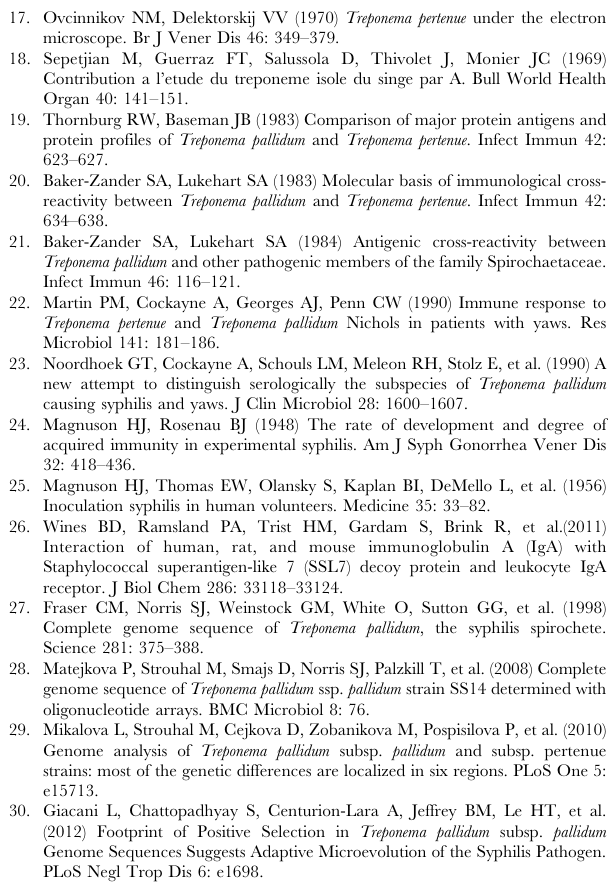
Figure S2 Alignment of amino acid sequences of the predicted protein sequences encoded at the tprD (2.1), tprC (2.2), and tprF and tprI (2.3) loci. The TprD2 truncated proteins encoded by the tprC/D loci in T. paraluiscuniculi , as well as by the tprF locus in T. p. pallidum strains are not included in the alignment for clarity purposes. Also, no T. paraluiscuniculi tprF and tprI ORFs are included because the tprF or tprI coding sequences are absent in the rabbit pathogen. DVR: Discrete variable regions. EL: External loops predicted by 3D models. SP: Predicted signal peptide. The last letter on the left column (strain name) indicates the locus where the predicted protein sequence is encoded. Red font, T. p. pallidum subspecies; blue T. p. pertenue ; brilliant green, T. p. endemicum ; and yellow, the Simian treponeme. (DOCX) Table S1 Primers used for amplification (1) or sequenc- ing (2). (DOCX) Table S2 GenBank accession numbers per locus and